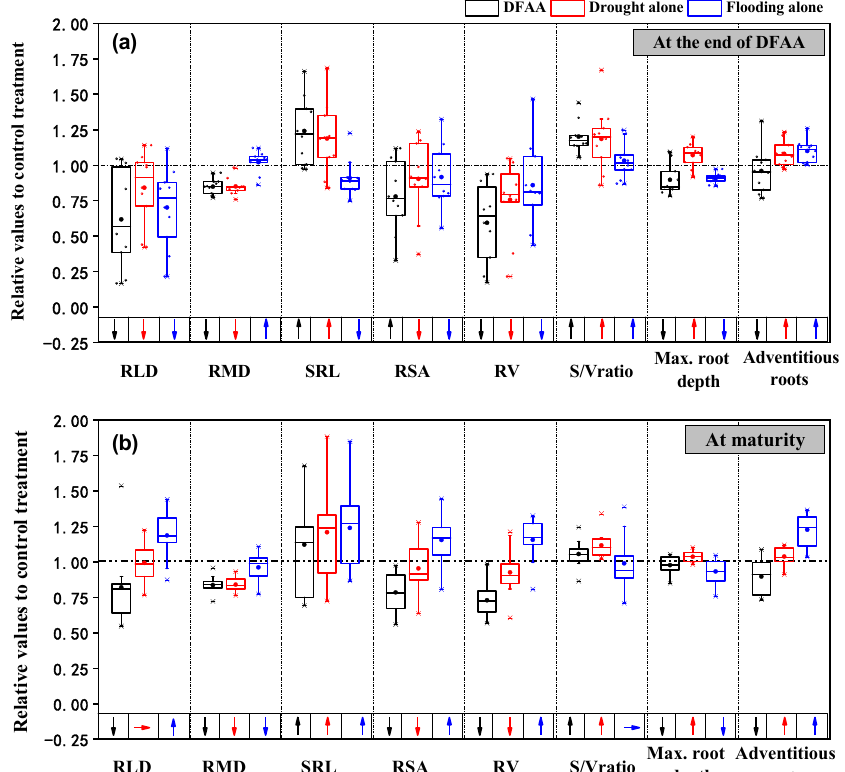
Figure 3. Changes of relative values of rice root traits under different water stresses ( a ) at the end of drought–flood abrupt alternation (DFAA) and ( b ) at maturity. Root traits include root length density (RLD, cm cm − 3 ), root mean diameter (RMD, mm), specific root length (SRL, m g − 1 ), root surface area (RSA, cm 2 pot − 1 ), root volume (RV, cm 3 pot − 1 ), the ratio of root surface area and root volume (S/V ratio, cm 3 cm − 3 ), maximum root depth (cm) and adventitious root numbers (no. pot − 1 ) under different water treatments. The boxes represent the range of relative values in rice root traits. Round dots ( • ) in the boxes represent the means for each group. The up arrow ( ↑ ) refers to the means of water stress groups greater than the value of the normal group; the down arrow ( ↓ ) refers to the means of water stress groups lower than the values of normal group; the flat arrow to the right ( → ) refers to the means of water stress groups comparable to the values of normal group.